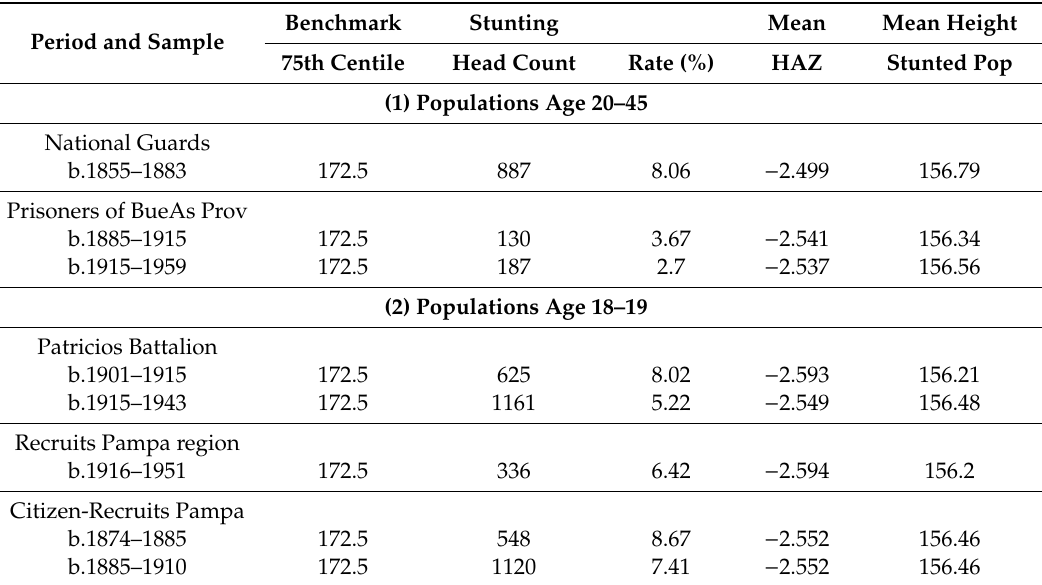
Table 7. Stunting rates estimated using the 75th centile as